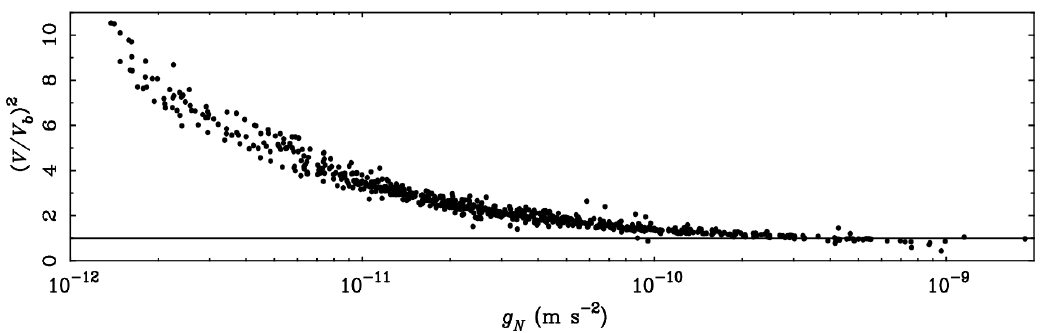
Figure 3. Mass-Discrepancy Acceleration Relation (MDAR), where the galaxy mass discrepancy, the squared ratio between the observed velocity V and the velocity due to baryons V b , is plotted against the Newtonian centripetal acceleration g N = V 2 / R derived from the observed baryonic surface b mass density. The black dots show several hundreds of individual resolved measured points from the rotation curves of almost one hundred spiral galaxies. The figure is reproduced from